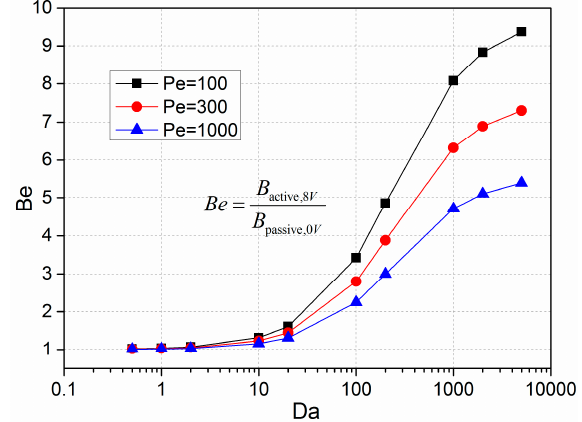
Figure 11. Binding enhancement factor Be with regard to the increasing Damkohler number at varying Peclet numbers Pe . The Peclet number is varied through changing the inlet flow velocity, while the Be factor is adjusted by varying the value of k on .